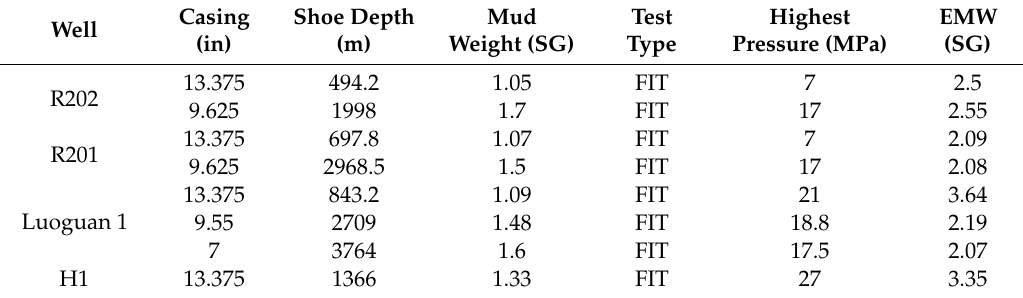
Table 6. Formation test